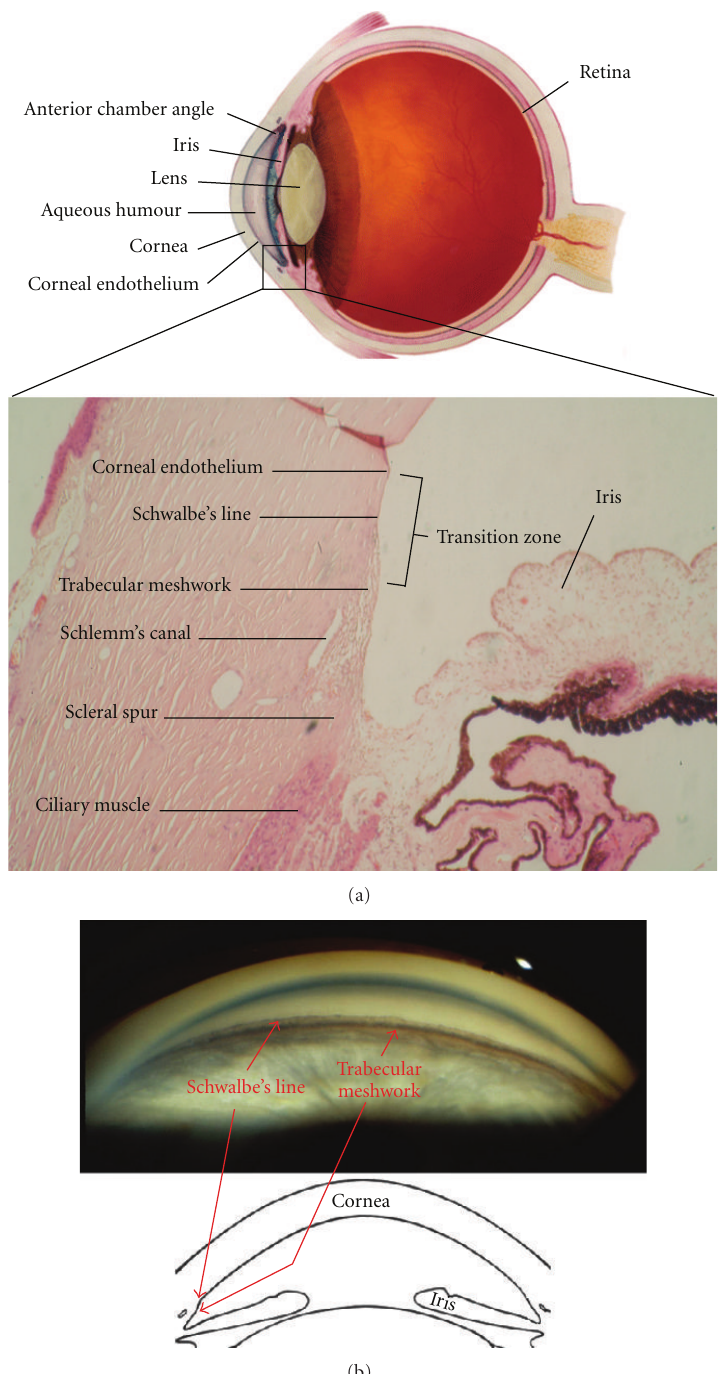
Figure 1: (a) Schematic diagram of the human eye and transverse section of haematoxylin and eosin stained chamber angle tissues ( × 100). (b) Anterior chamber angle as viewed in